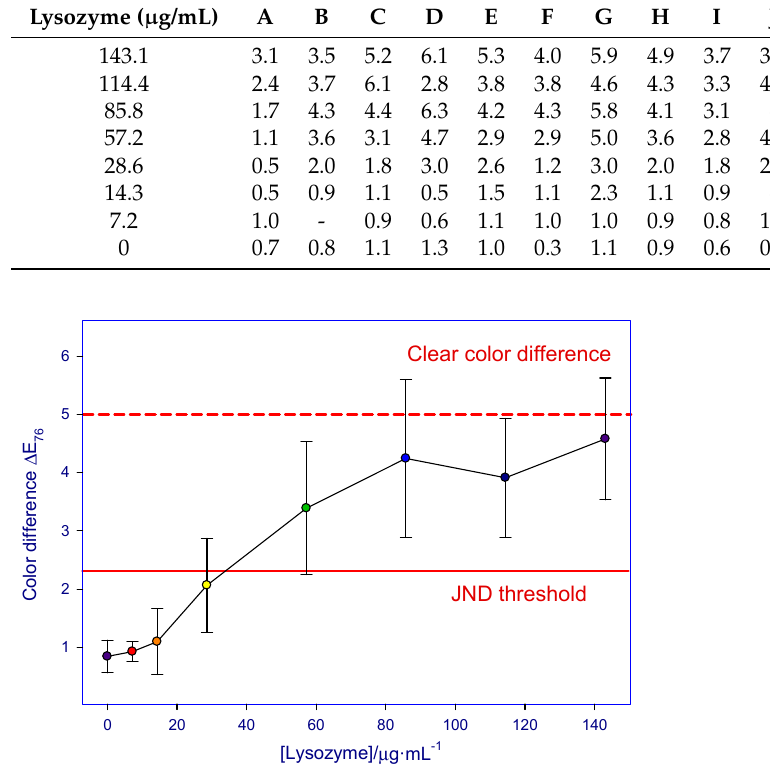
Figure 8. Mean color difference ∆ E 76 evolution for samples A–J with increasing lysozyme concen- trations.